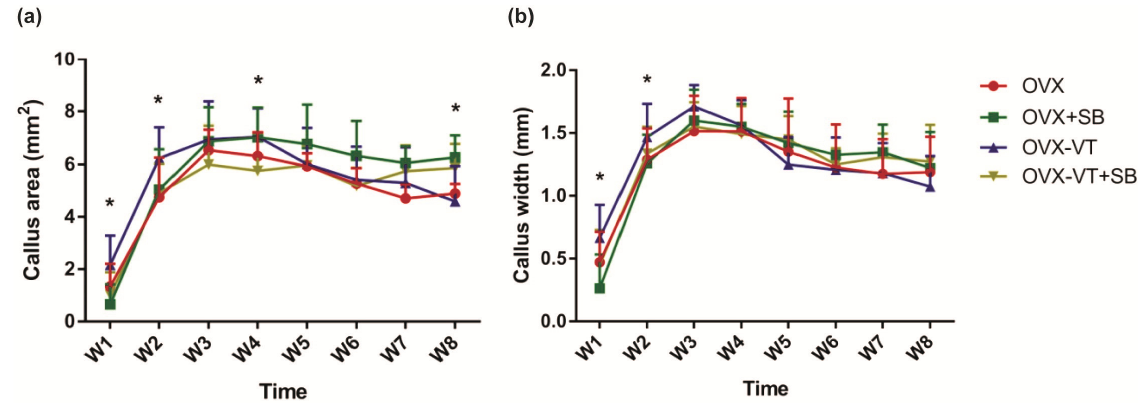
Figure 3. Histomorphometry of callus size. ( a ) VT enhanced the callus area as soon as weeks 1 and 2, with statistically significant difference, and lasted until week 4; ( b ) Callus width was higher in the OVX-VT treatment group compared to the other group in weeks 1 and 2. * Statistical significance considered at p < 0.05, one-way ANOVA with post-hoc Bonferroni test. Abbreviation: W: week.